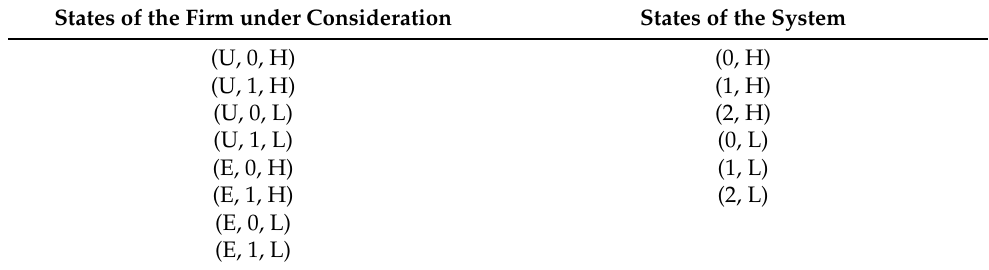
Table 2. States of the firm under consideration and states of the system with two active firms.